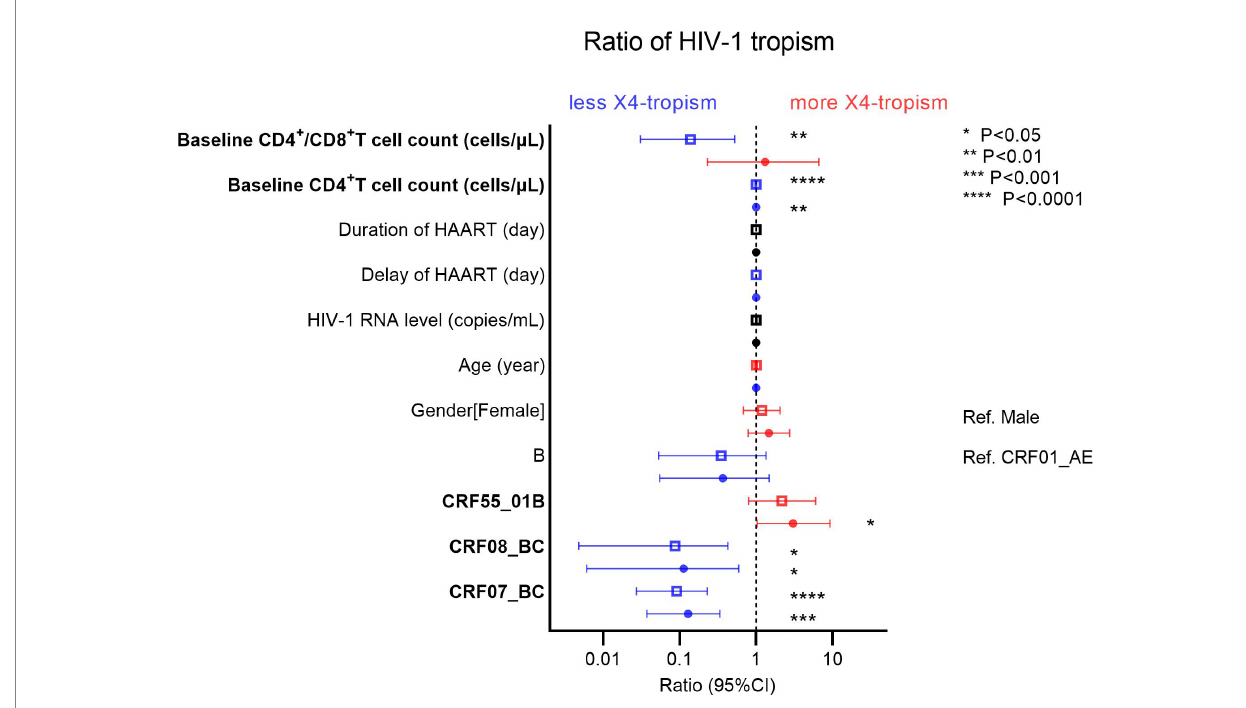
FIGURE 5 Univariate (hollow square) and multivariate (solid circle) logistic regressions of factors associated with HIV-1 tropism. The blue pattern represents the odds ratio of less than 1, while the red pattern represents the odds ratio of more than 1.